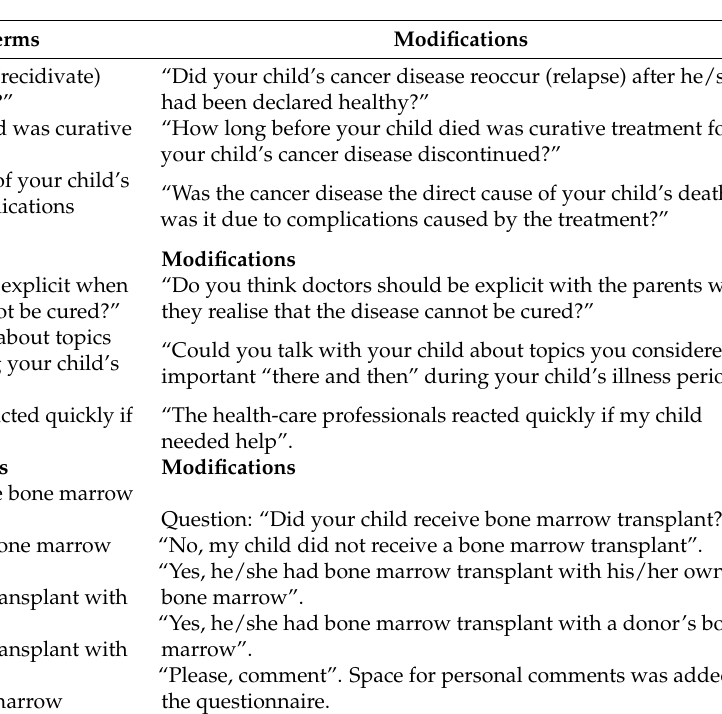
Table 2. Issues and modifications revealed after